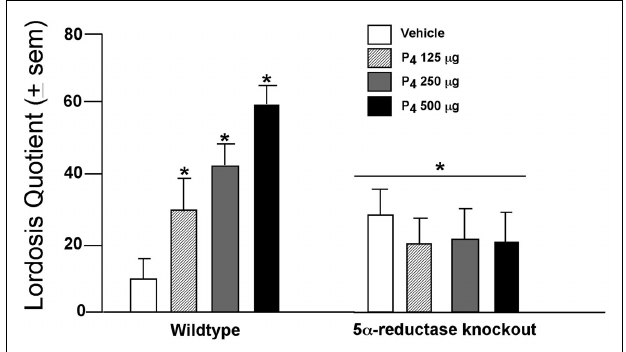
FIGURE 1 | Lordosis is enhanced dose-dependently when progesterone (P 4 ) is administered (SC) to wild-type mice but not those deficient in 5 α -reductase (KO). ∗ Indicates p < 0.05 differences from wild-type mice administered